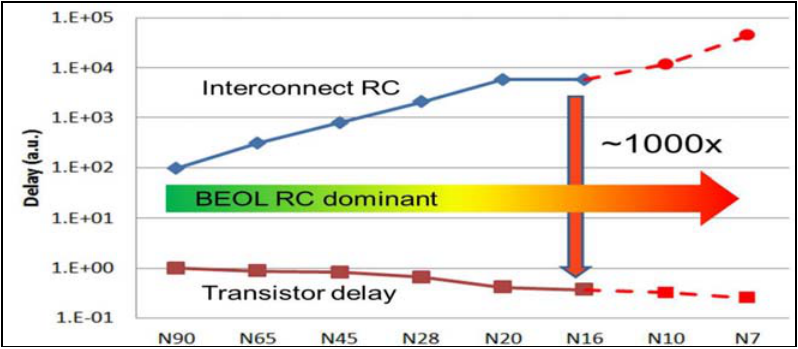
Figure 1. Growing gap between transistor delays and interconnect delay in advanced technology nodes. Reproduced with permission from [5], IEEE, 2013.